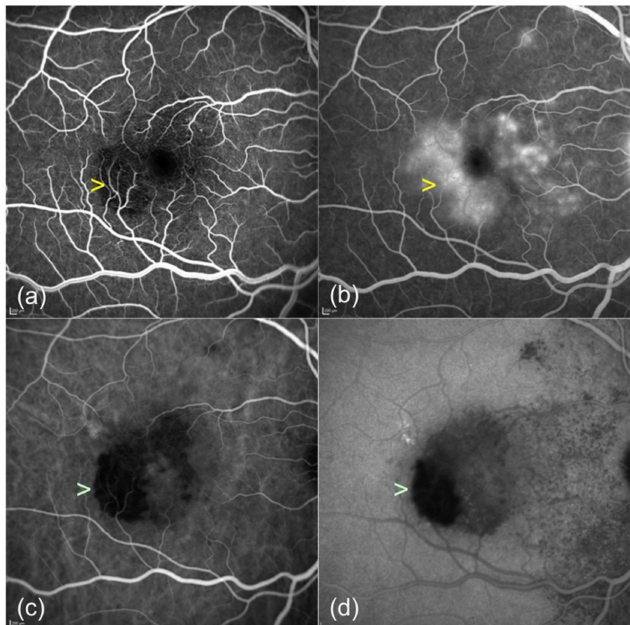
Figure 1: Fluorescein angiography (FA) and indocyanine green angiography (ICGA) of acute syphilitic posterior placoid chorioretinitis in the right eye at presentation. (a) Early frame of FA shows hypofluorescence (yellow arrowhead) of the placoid lesion which appears hyperfluorescent in the late frames (b). (c), (d) ICGA shows hypocianescence of the placoid lesion (green arrowhead) throughout the whole examination.